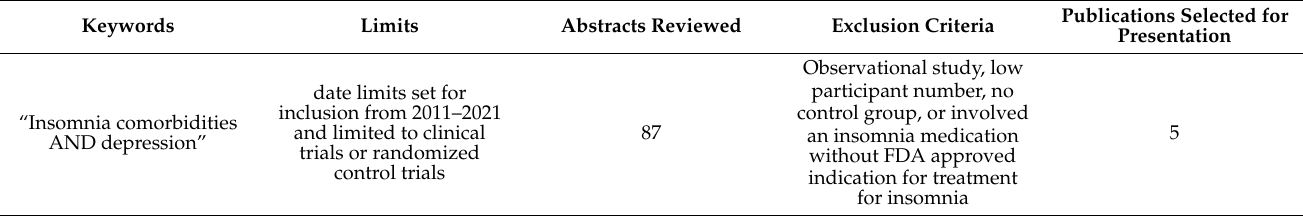
Table 1. Literature search method with keywords, limits and exclusion